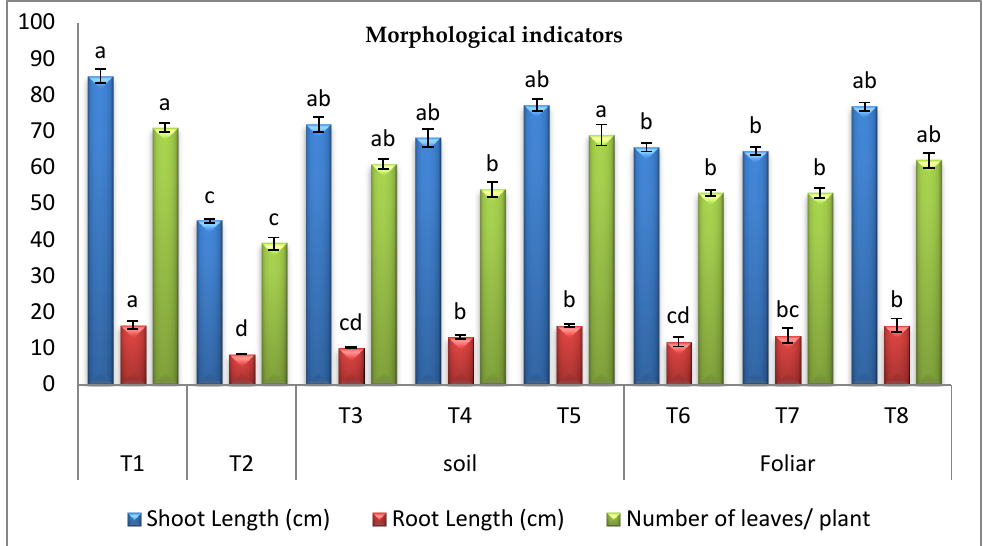
Figure 2. Effect of cyanobacteria on morphological traits of the infected pepper plant with Fusarium wilt (T1-healthy control, T2-infected control, T3-infected plants treated with D. muscorum soil, T4- infected plants treated with A. oryzae soil, T5-infected plants treated with A. platensis soil, T6-infected plants treated with D. muscorum foliar spray, T7-infected plants treated with A. oryzae foliar spray and T8-infected plants treated with A. platensis foliar application.) (Data represent mean ± SD, n = 3), (a–d Letters revered to significant in statically analysis).